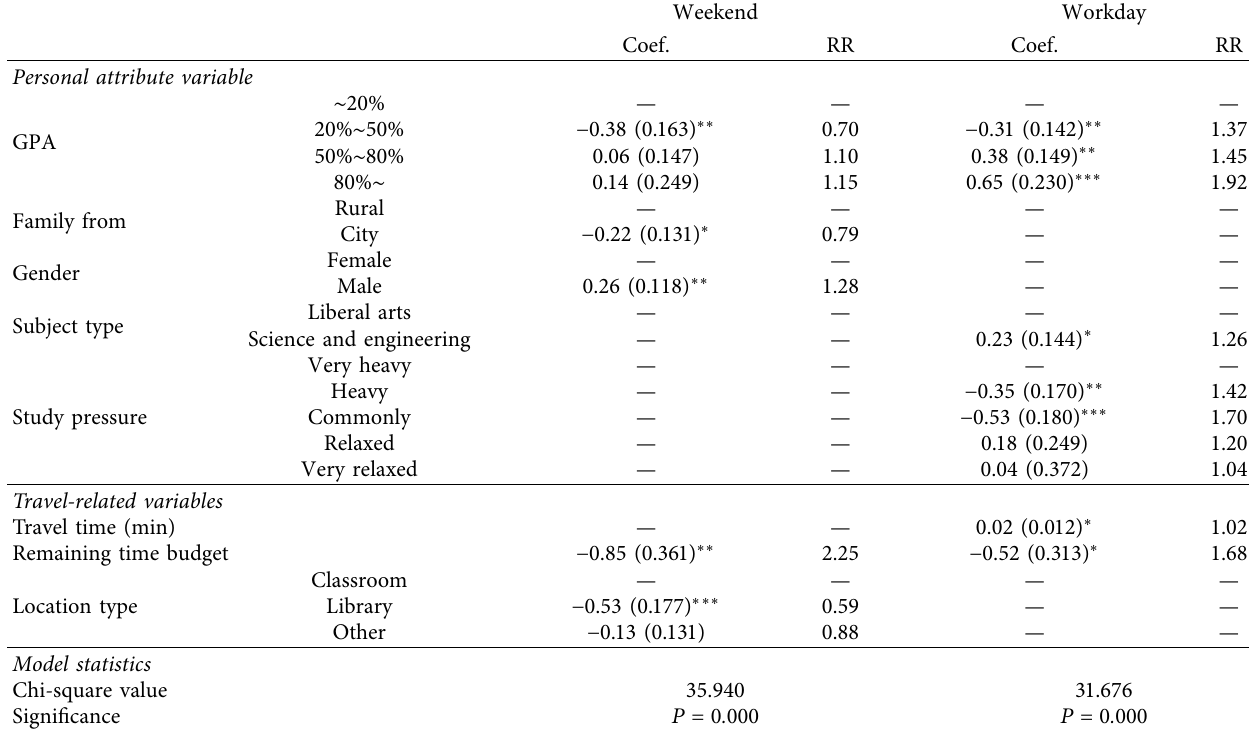
Table 6: Cox regression